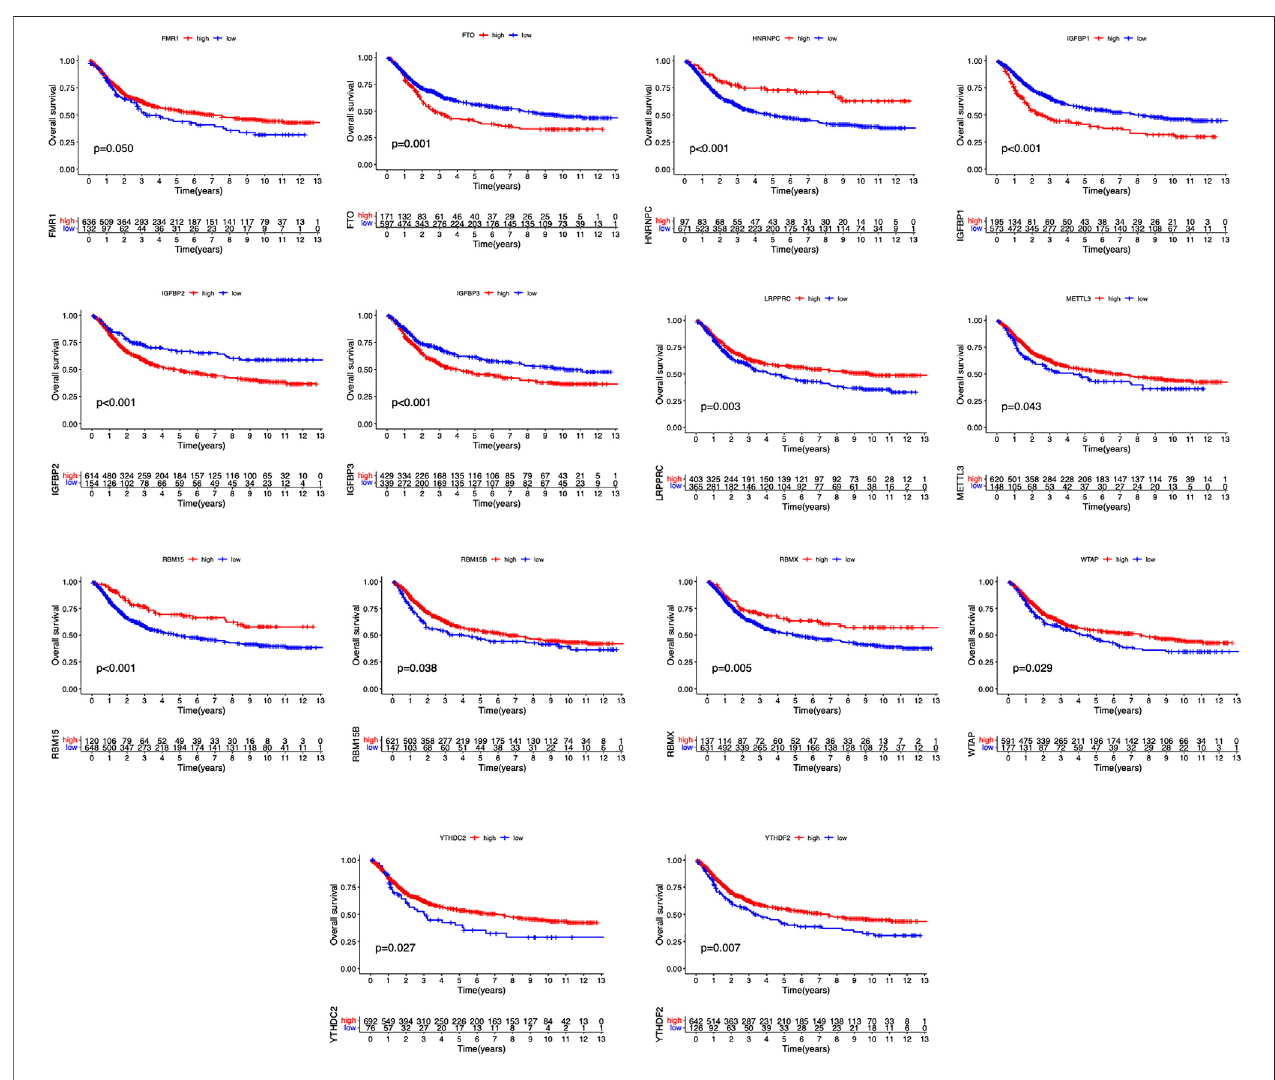
FIGURE 1 | Survival curves of m6A regulatory genes in